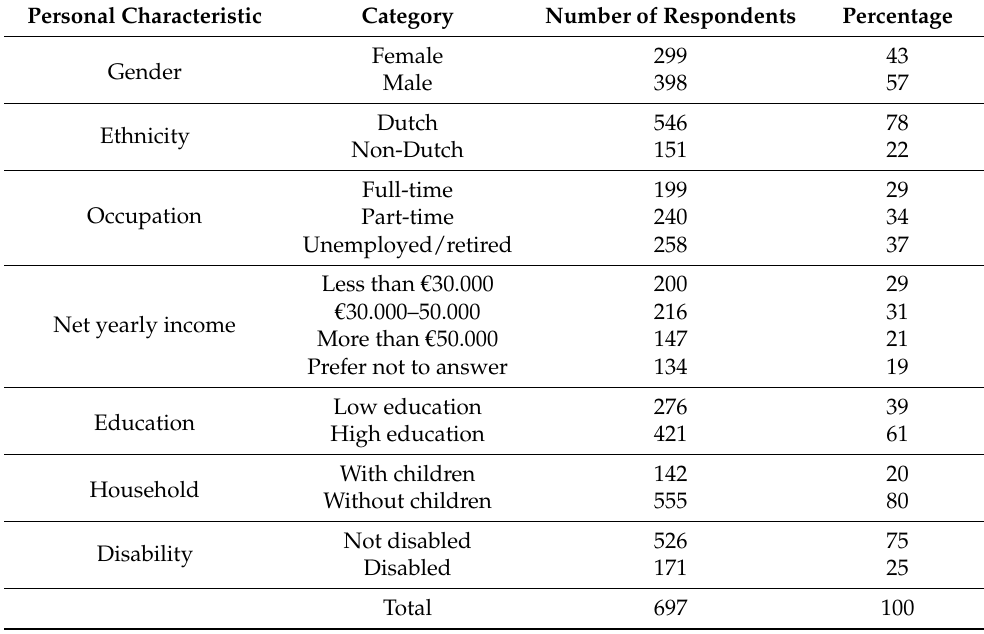
Table 2. Socio-demographic characterization of the